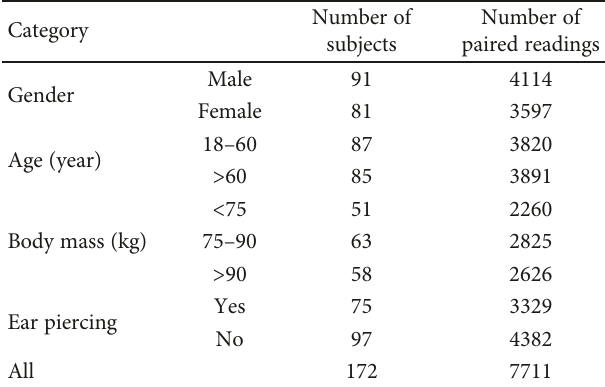
Table 1: Patient characteristics and the number of paired GlucoTrack-invasive